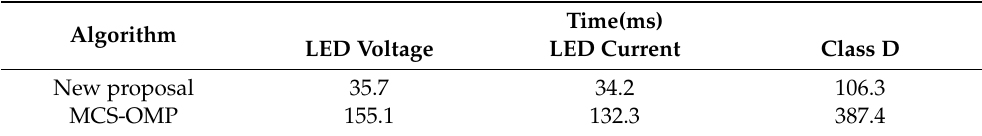
Table 6. Calculation time